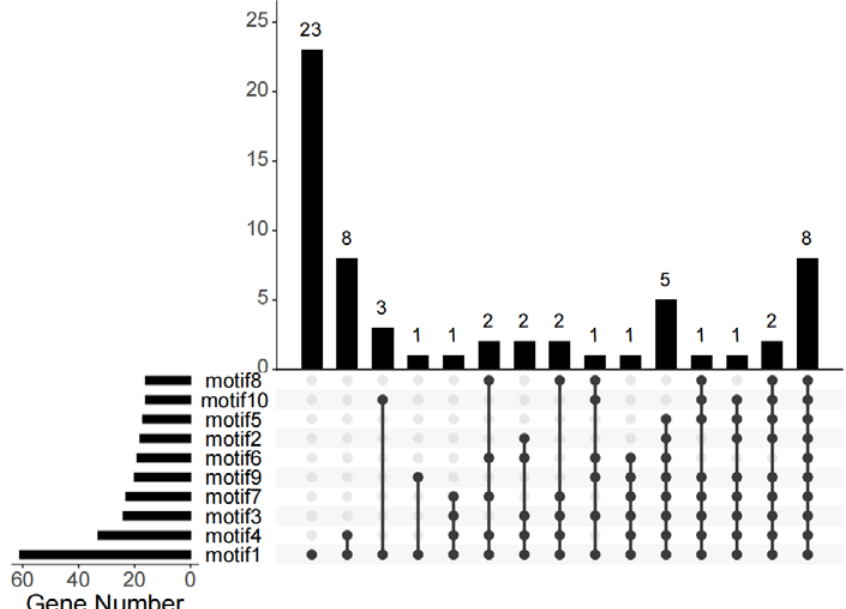
Figure 1. Distributions of motifs in Brassica GYFs and AtGYFs . The UpSet plot shows the distribution of motifs in Brassica GYFs and AtGYFs . The number chart above represents the number of genes contained in each type of GYF s. The bar chart at the bottom left represents the number of events included in each type of motif. The dotted line shows the type of motifs contained in the group.